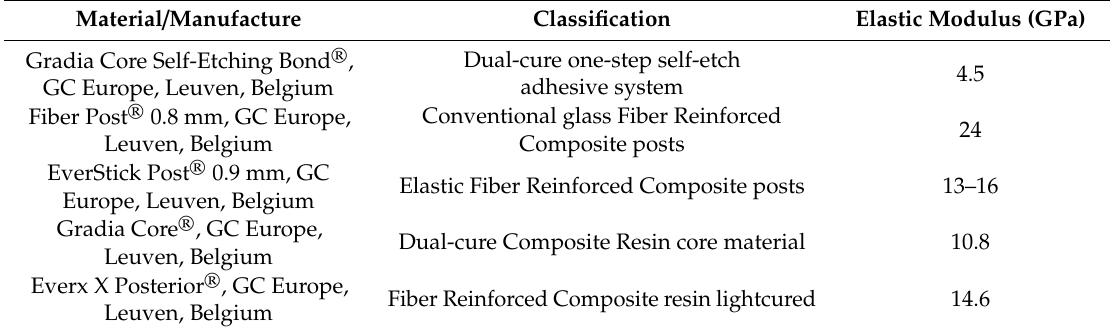
Table 2. Restorative materials description.